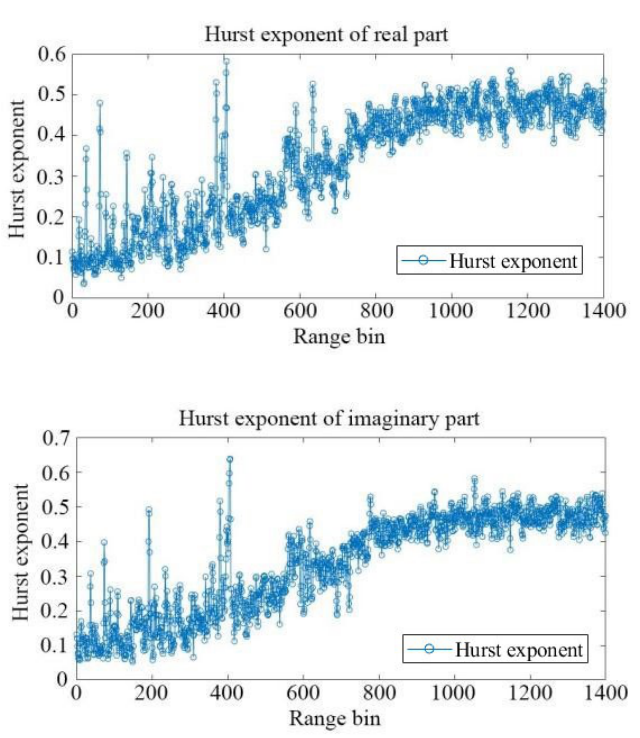
Figure 3. The Hurst exponent H of real part and imaginary part of sea clutter for each range bin. parts are almost identical. The slight difference is due to estimation error of the